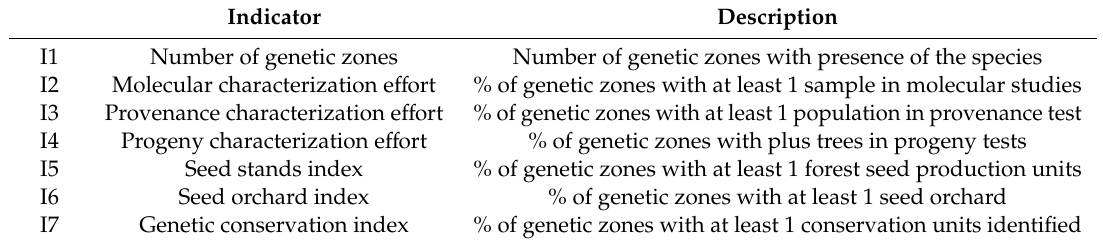
Table 1. Indicators of the genetic zones in conservation and management of genetic resources.